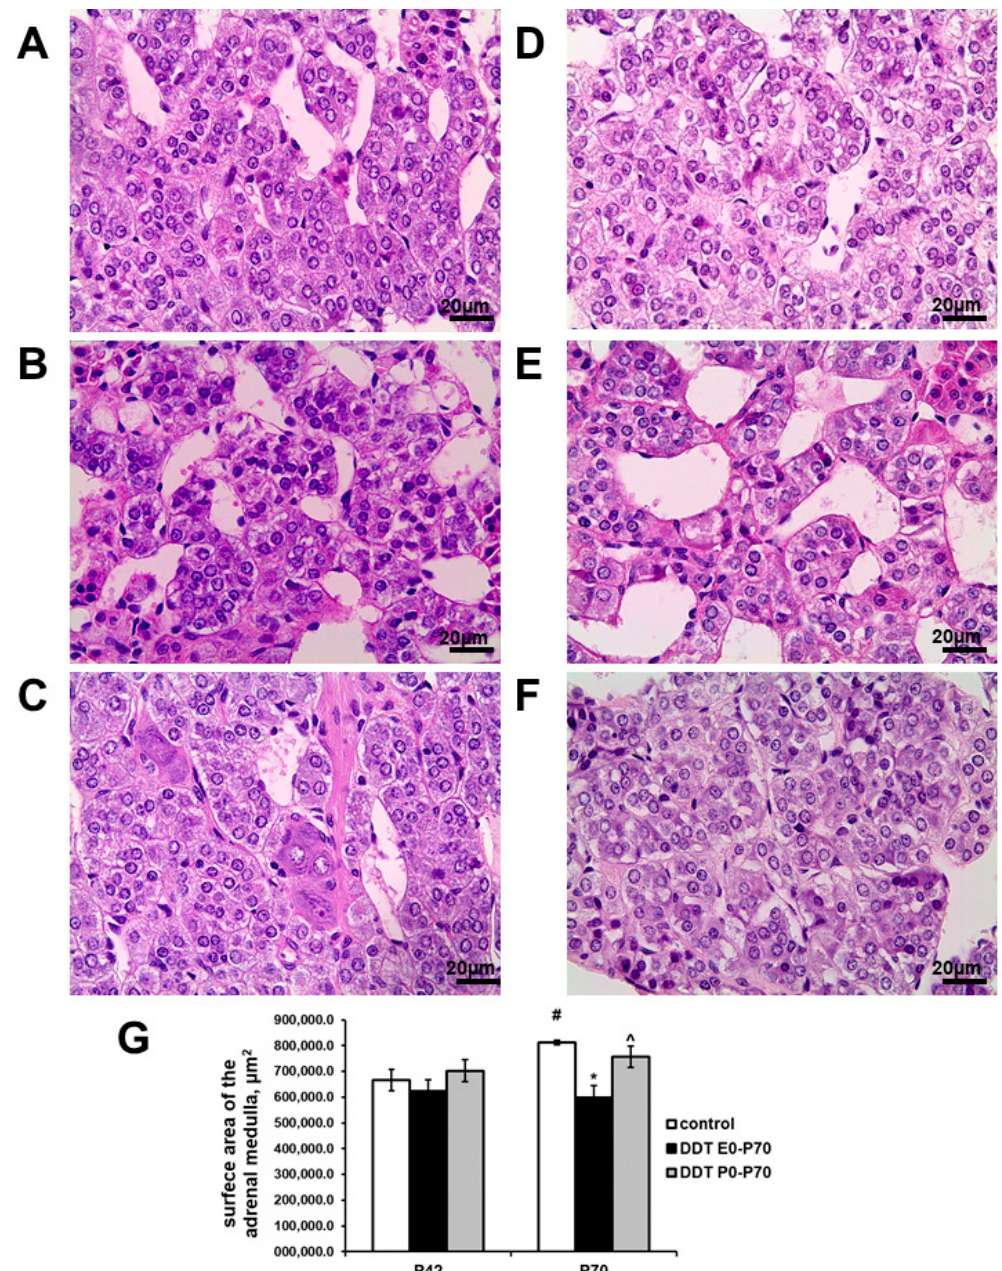
Figure 2. Changes in the histology of the adrenal medulla after developmental exposure to low doses of o,p’-DDT. Histology of the adrenal medulla of the control rats ( A ), prenatally and postnatally exposed to DDT rats ( B ) and postnatally exposed to DDT rats ( C ) in pubertal period (P42), of the control rats ( D ), prenatally and postnatally exposed to DDT rats ( E ) and postnatally exposed to DDT rats ( F ) after puberty (P70). Magnification 400. ( G ) Surface area of the adrenal medulla. Data are shown as mean ± S.E.M. P, day of postnatal development; p < 0.05 compared to the control (*), compared to the group DDT E0-P70(^), compared to P42 (#).